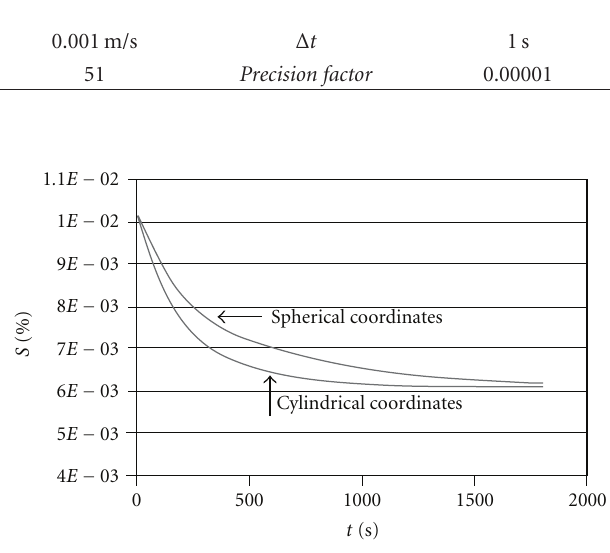
Figure 2: Sulfur elimination against time, node 10, T = 1400 ◦